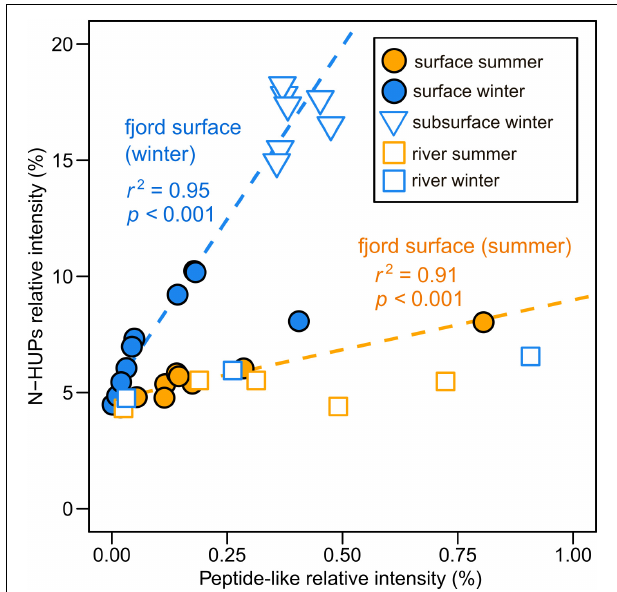
FIGURE 5 | Relationship between FT-ICR MS relative intensities of nitrogen-containing highly unsaturated and phenolic compounds (N-HUPs) and peptide-like formulae in the surface layer and subsurface waters of Baker-Martinez Fjord and its tributary rivers. Separate linear regression lines ( n = 9 with normally distributed residuals) used to illustrate the difference in the relationship between seasons for fjord surface layer samples (winter regression excludes the one outlier sample).